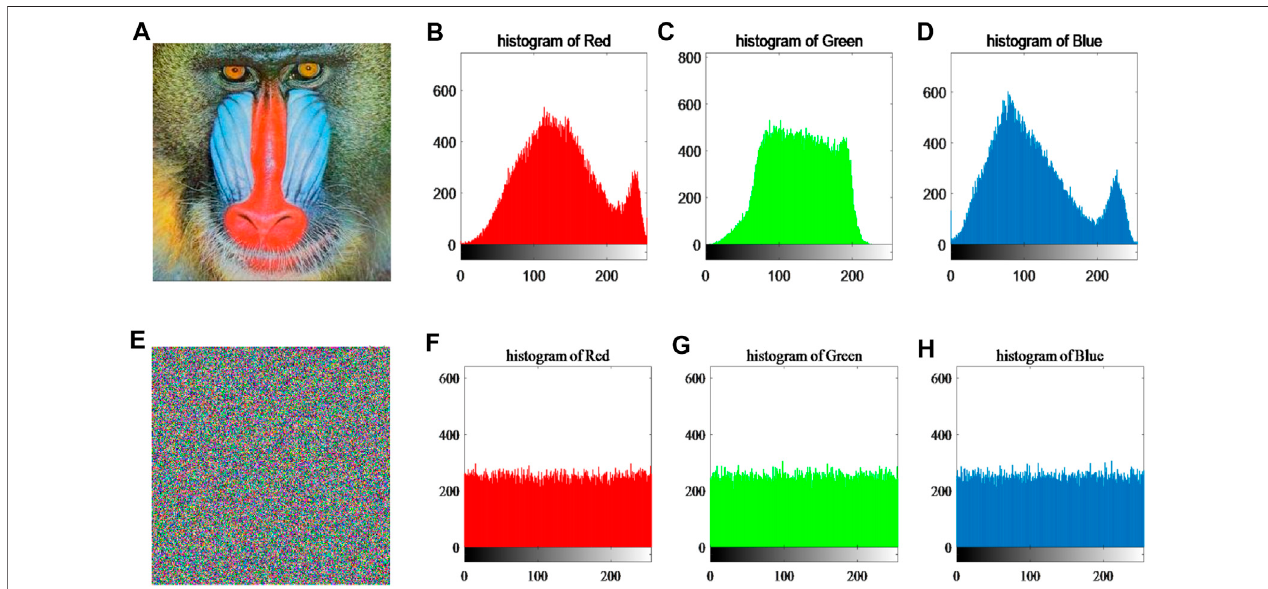
FIGURE 15 | The histogram simulation results of the original image and encrypted image. (A) original image; (B) , (C) and (D) are histograms of R , G and B pixel channels of the original image, respectively; (E) encrypted image; (F) , (G) and (H) are histograms of R , G and B pixel channels of the encrypted image, respectively.